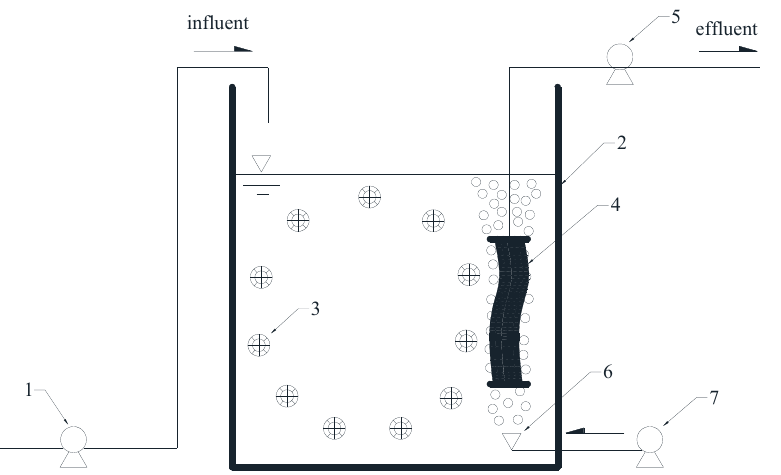
Figure 1. Schematic diagram of the HMBR setup. 1 feed pump; 2 aeration tank; 3 biological medium; 4 membrane module; 5 peristaltic pump; 6 air diffuser; 7 air compressor.